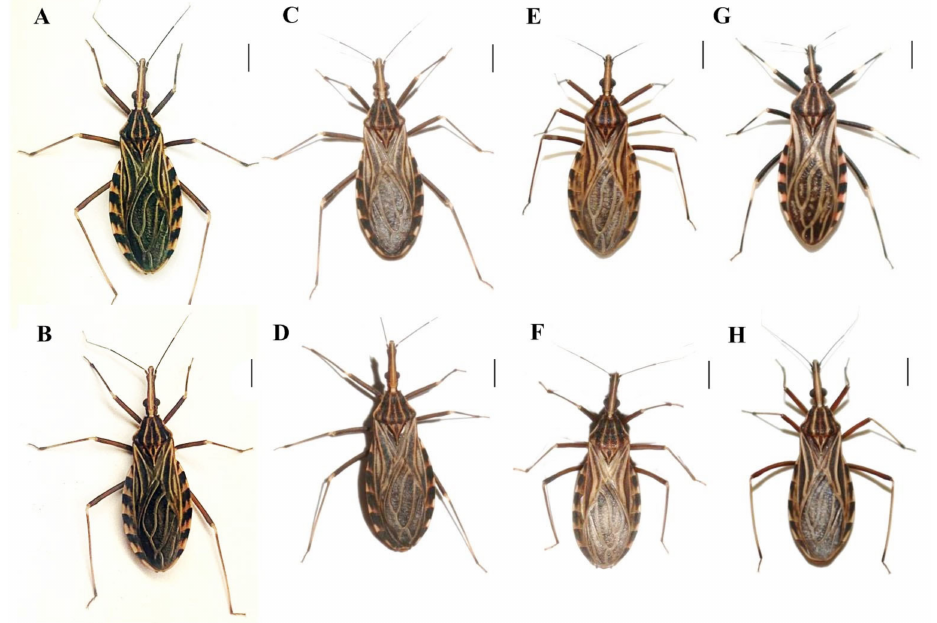
Figure 2. Hybrids resulting from crosses between species of the Rhodniini tribe. Hybrids resulting from crosses between R. milesi